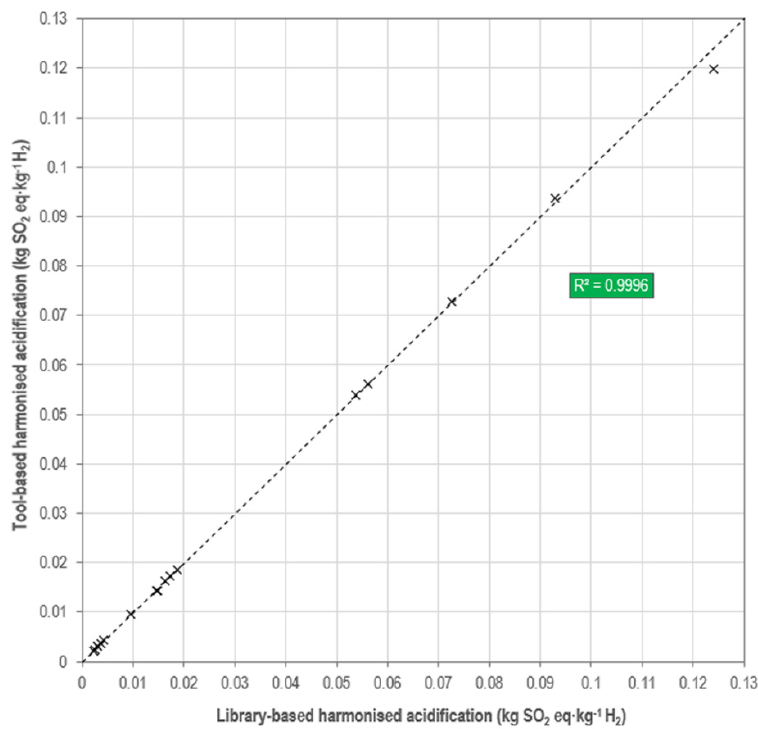
Figure 4. Linear regression between library- and tool-based harmonised acidification.